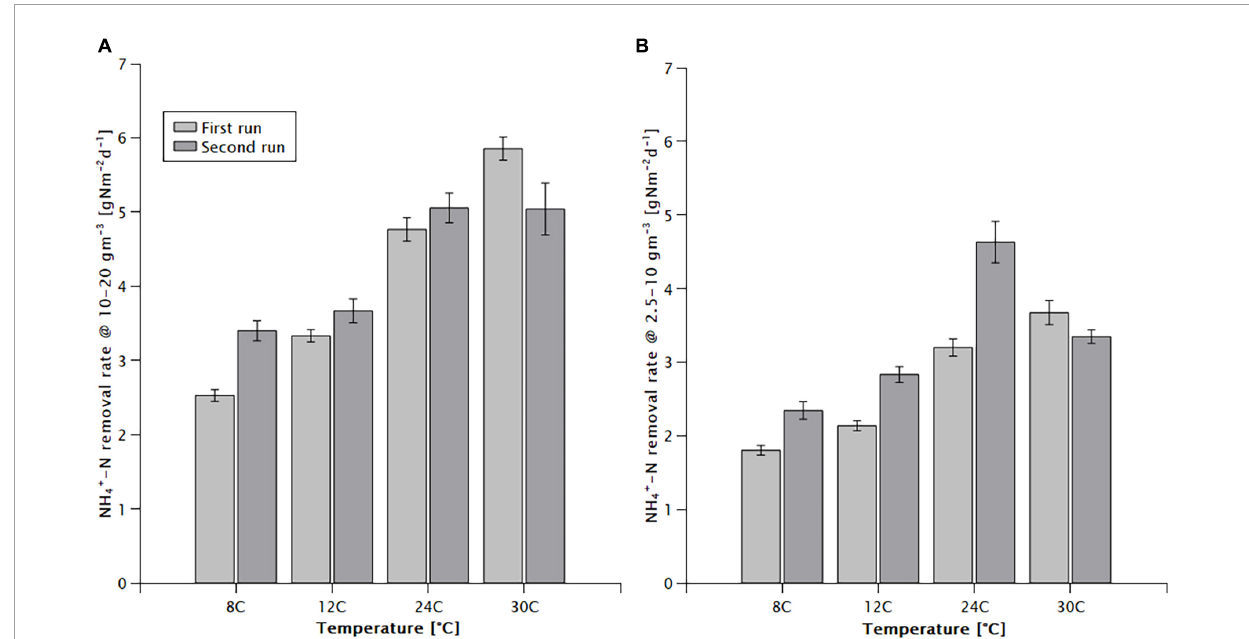
FIGURE1 Effect of temperature on the NH 4 + -N removal rate of the MABR in the (A) high (10–20 mg/L) and (B) low (2.5–10 mg/L) initial NH 4 + -N concentration ranges.